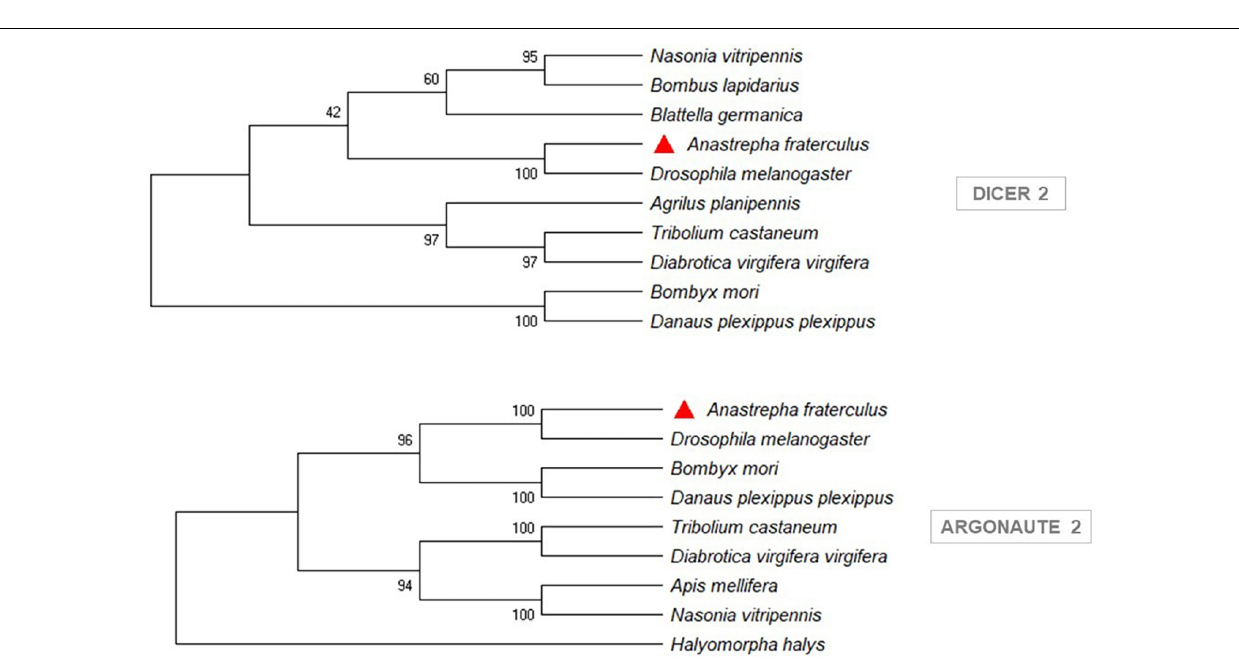
FIGURE 3 | Phylogenetic trees of siRNA pathway genes, Dicer 2 ( Dcr-2 ) and Argonaute 2 ( Ago-2 ). MEGA X was used to construct the phylogenetic trees with Neighbor-Joining method. Anastrepha fraterculus sequence from transcriptome was marked with a red triangle. All accession numbers are shown in Supplementary Table S4